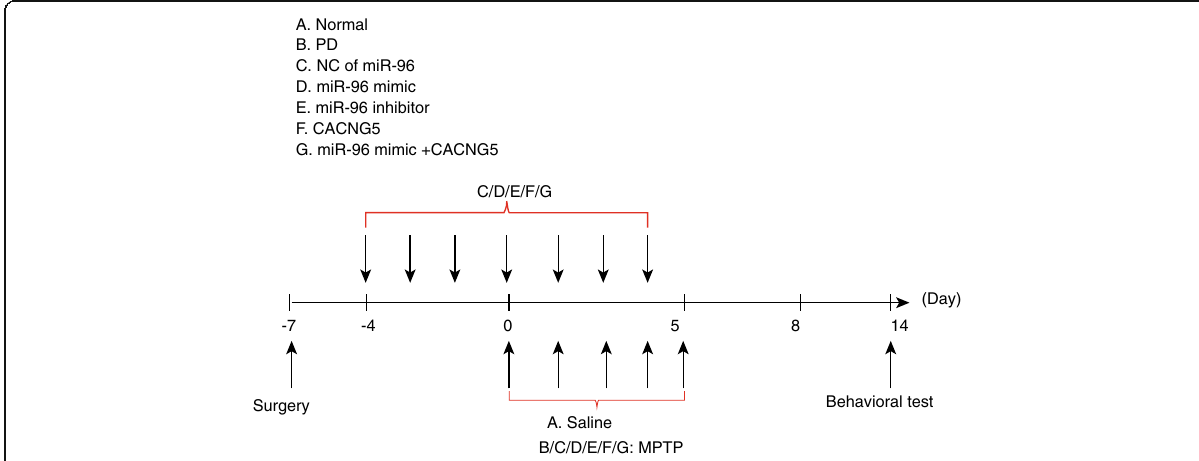
Fig. 1 The flowchart of model establishment and behavioral test. The horizontal axis represents the time points after the